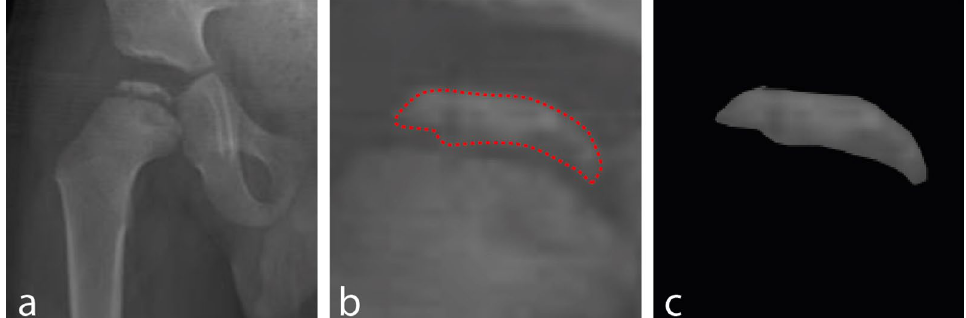
Figure 3. Obtaining the femoral head from the image ( a ) Hip radiograph of LCPD Group C ( b ) Femoral head pointed in red ( c ) The highlighted head is segmented from the image and assigned as the final test